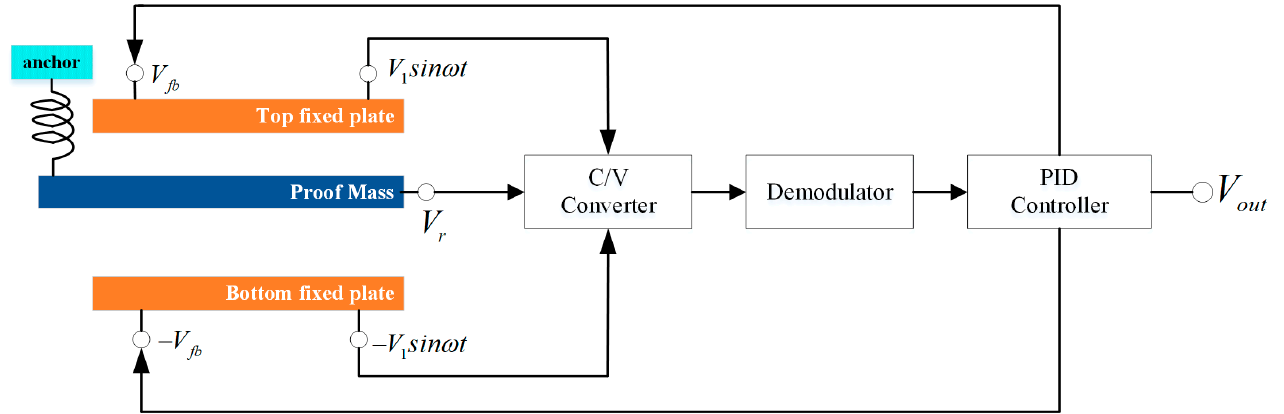
Figure 1. S ketch map of servo system in MEMS accelerometer. Figure 1. Sketch map of servo system in MEMS